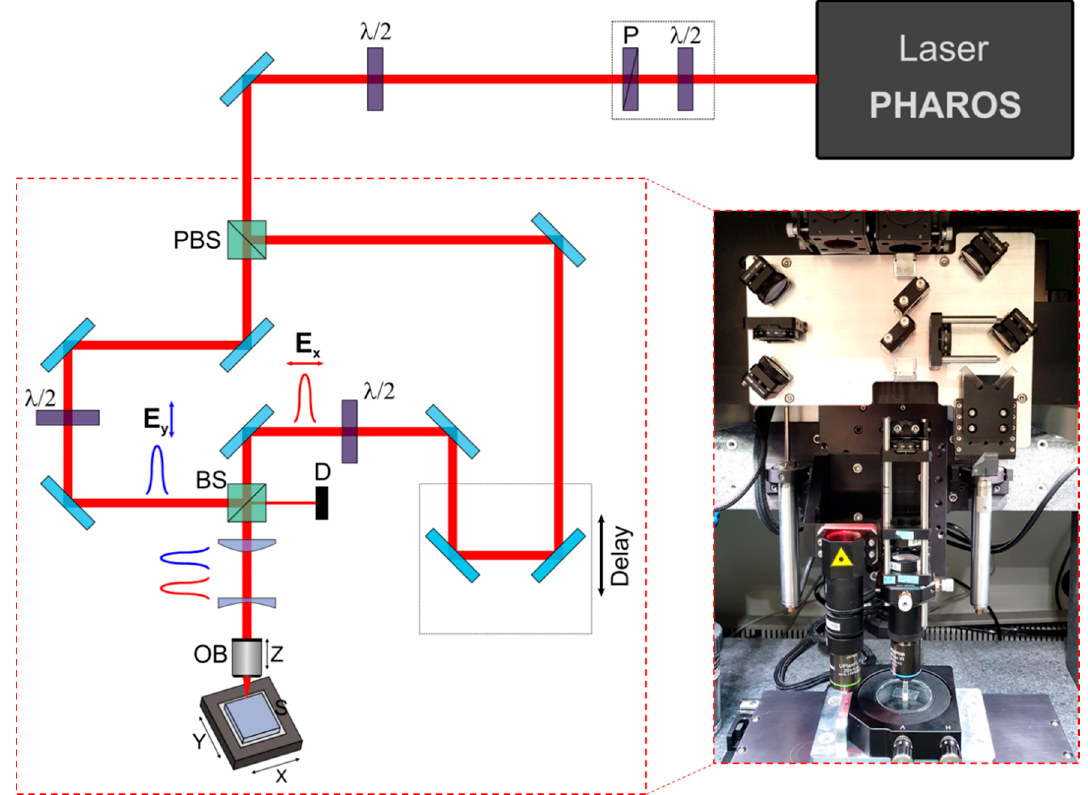
Figure 1. The double-pulse experimental setup. P—Brewster angle polarizer, PBS—polarising beam splitter, BS—beam splitter, D—dump, OB—microscope objective.